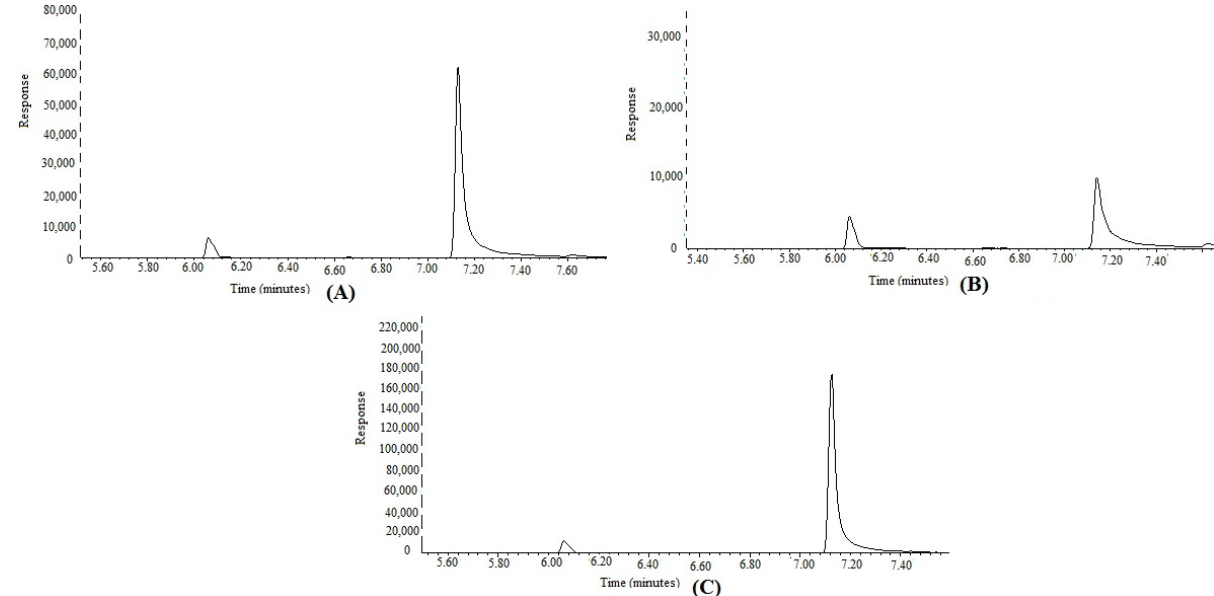
Figure 7. Representative GC-MS peaks of FCO and TOH in methanolic extracts of F. vulgare obtained from ( A ) IND, ( B ) PAK, and ( C ) SA.